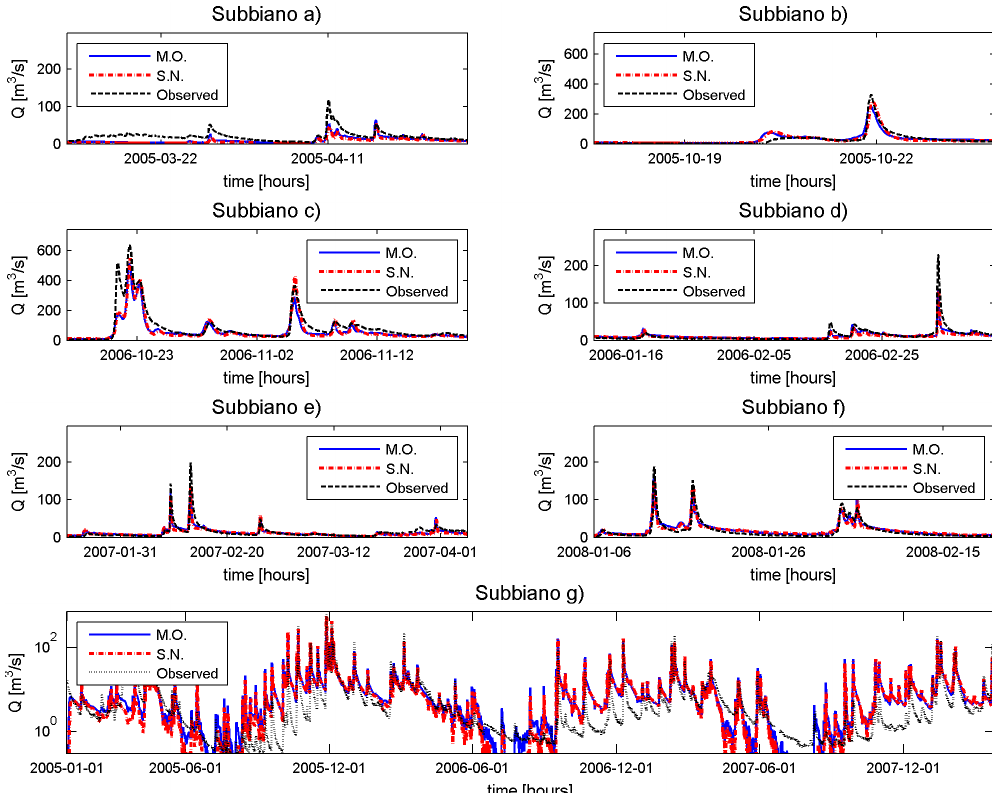
Figure 15. Observed streamflow for the Casentino basin compared with simulations obtained using the M. O. and S. N. parameter sets for the period 2005 to 2007. Time is reported on x axis and streamflow on y axis. The bottom subpanel shows the entire period with log scale on y axis. The other subpanels show the main flood events with linear scale on y